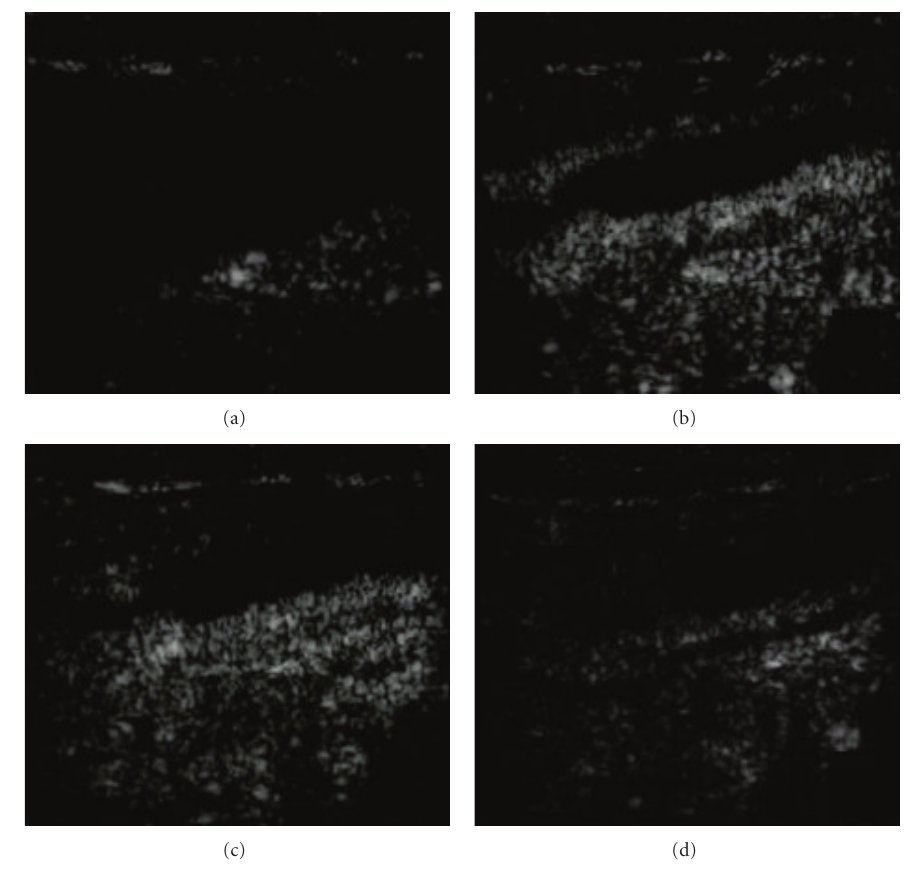
Figure 4: CEUS. Last ileal loop wall thickening and submucosal contrast enhancement after contrast medium (SonoVue, Bracco). 0 (a), 15 (b), 30 (c), and 45 (d)